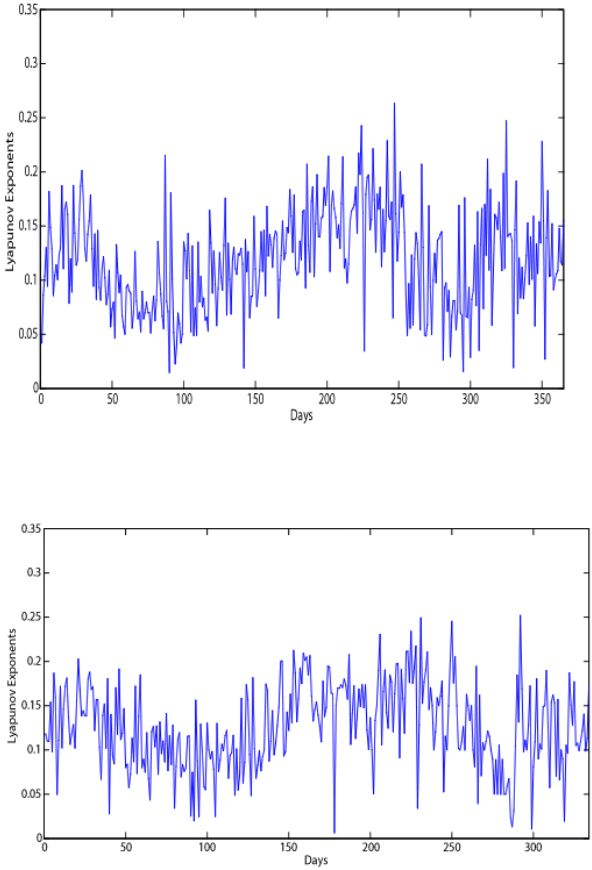
Figure 7. (a) The transient variations of Lyapunov exponents for 365 days of 2011 for detrended TEC measured at Enugu. (b) The transient variations of Lyapunov exponents for 334 days (1 January–30 November) of 2011 for detrended TEC measured at